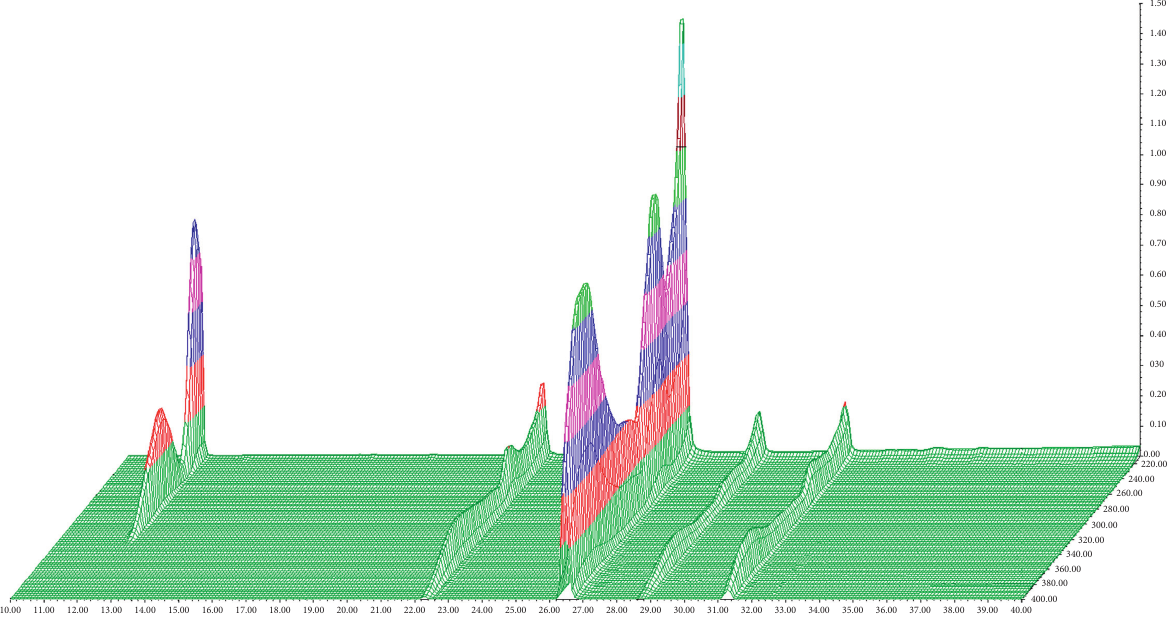
Figure 2: Full spectrum scan of five compounds.